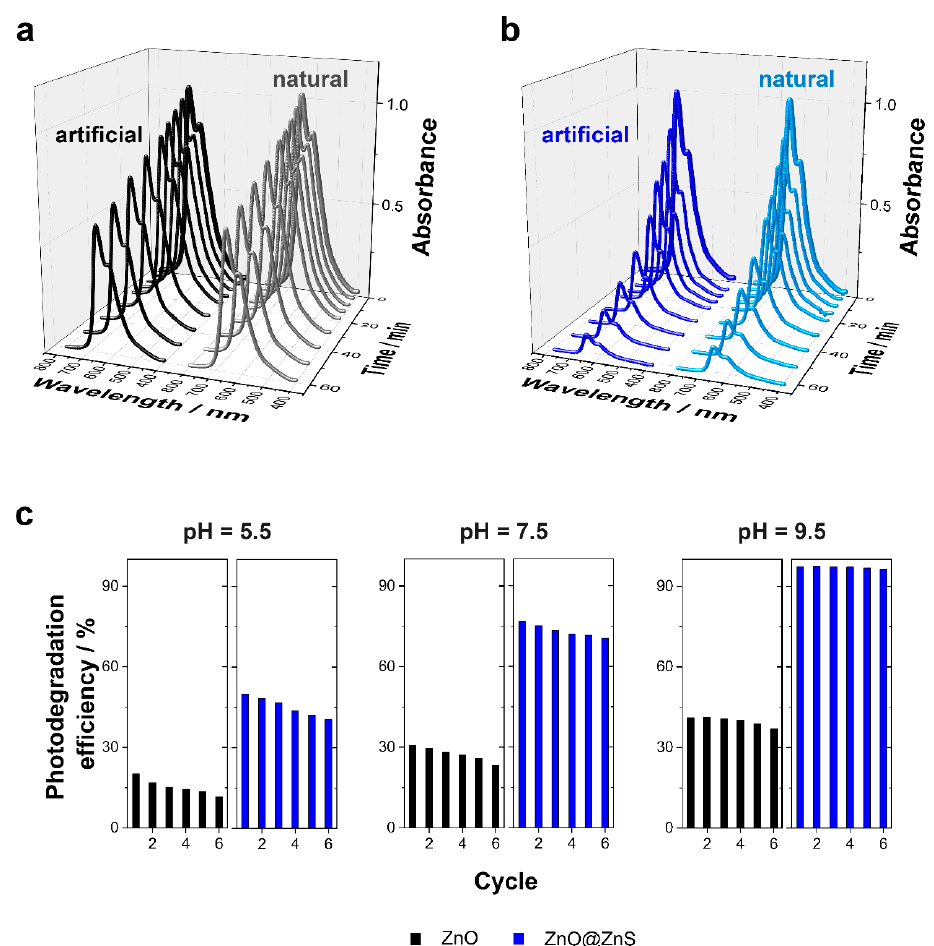
Figure 5. Time-dependent UV-vis spectra of MB (5 ppm) photocatalytically degraded under artificial and natural UV-filtered ( λ > 400 nm) sunlight in the presence of 0.4 mg mL − 1 of ( a )